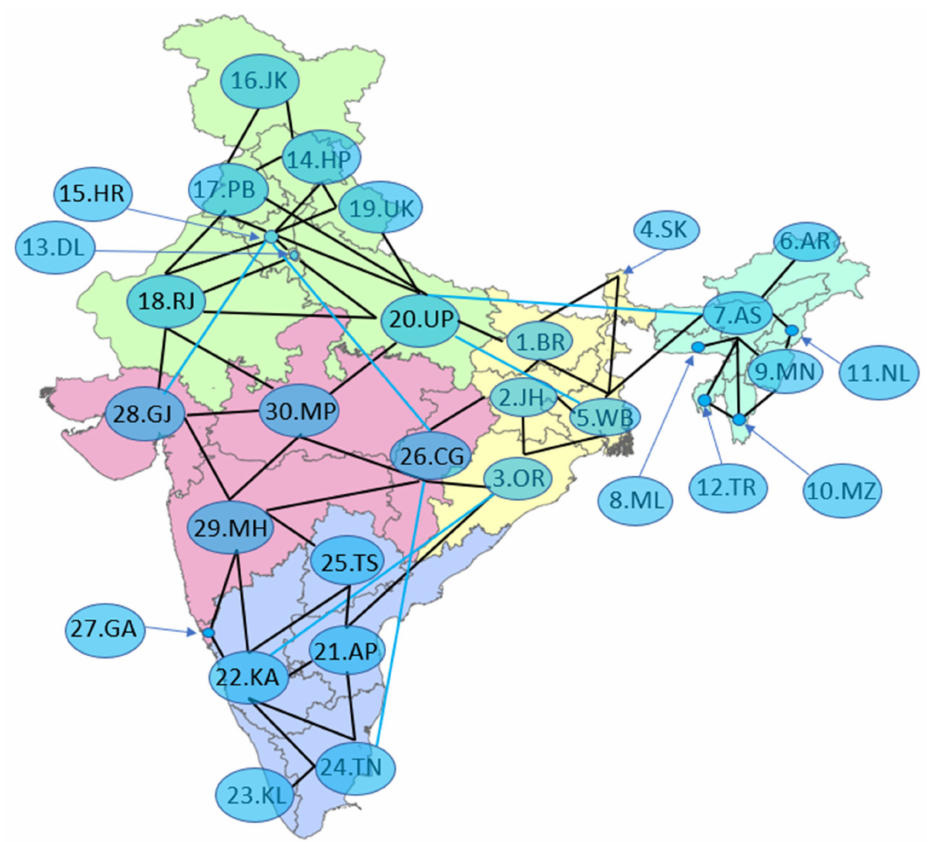
Figure 3. Diagram of the electricity grid of India, with the 62 transmission lines appearing where six of them are HVDC (shown in